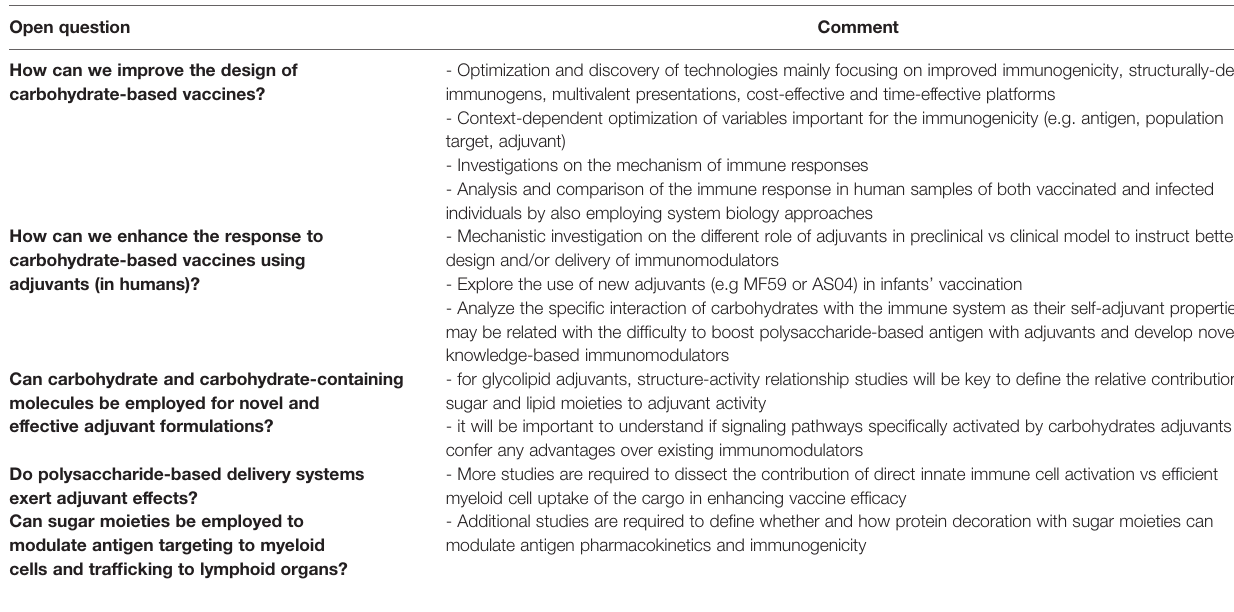
TABLE 2 | Open scienti fi c questions on carbohydrate-based vaccines and adjuvants. Open